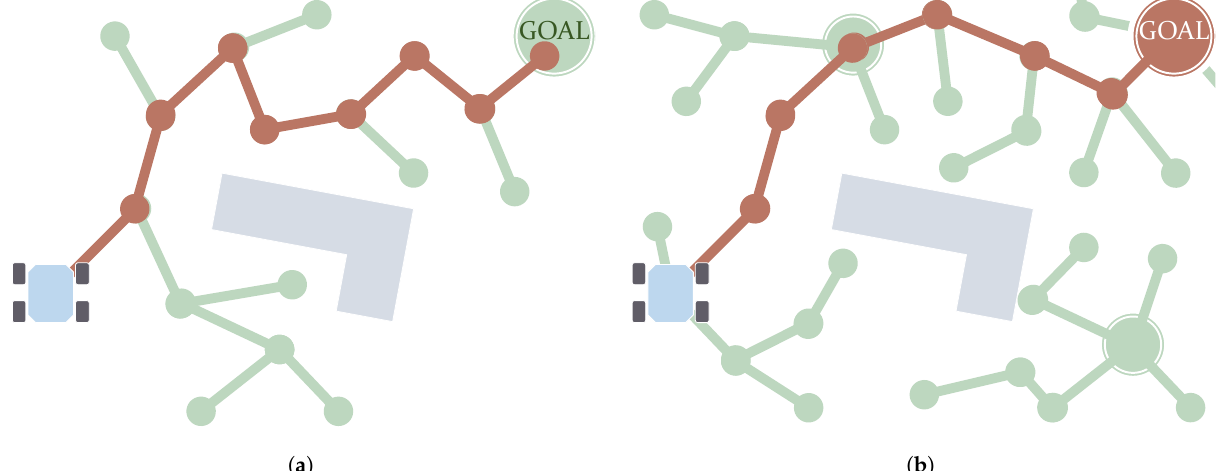
Figure 10. Example cases of single-query ( a ) and multiple-query ( b ) Sampling-Based algorithms. Samples are created in an iterative way until the destination is